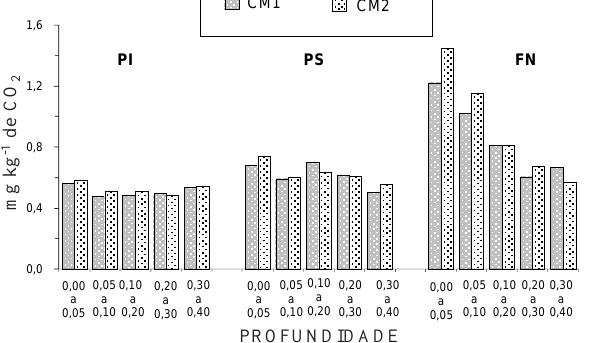
Figura 4. Carbono orgânico lábil nos agregados maiores e menores que 0,25 mm, respectiva- mente (CL1 e CL2), de solos sob plantio direto irrigado (PI), plantio direto de sequeiro (PS) e floresta nativa (FN), em cinco profundidades.